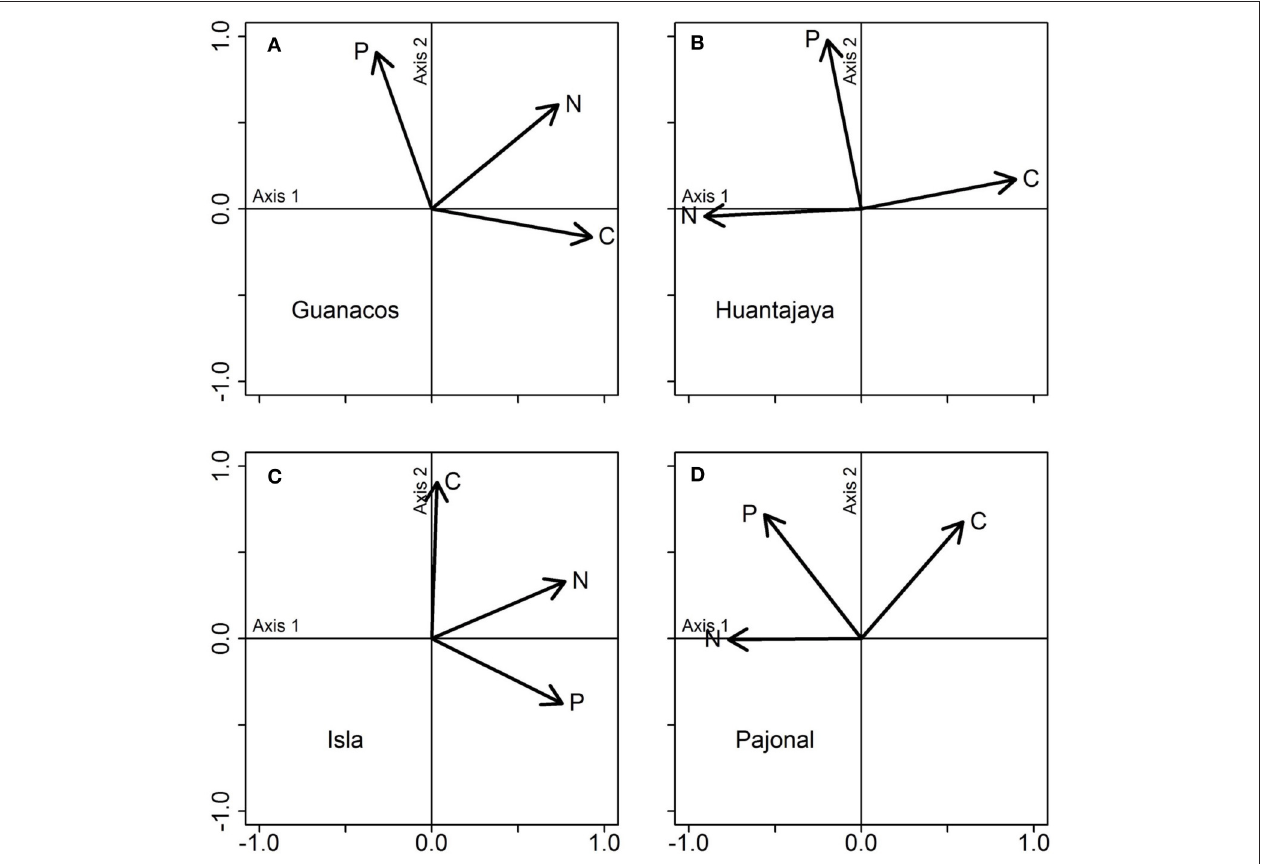
FIGURE 10 | PCA on the stoichiometric traits of four geographically distinct populations of a predatory species (Arachnida, Solifugae, Ammotrechidae sp.). Each plot represents a PCA conducted separately for each population, using the data displayed jointly in this figure. As in this figure, populations are labeled according to the sites where they were collected: Guanacos (A) , Huantajaya (B) , Isla (C) , and Pajonal (D) . Vectors show the influence of the three stoichiometric traits (C, N, and P contents) on each PCA